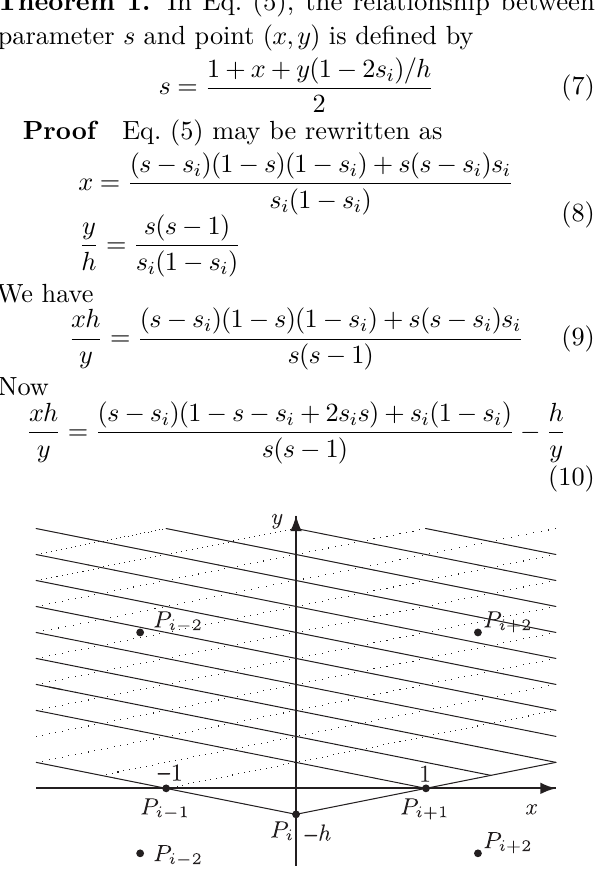
Fig. 1 Five data points after